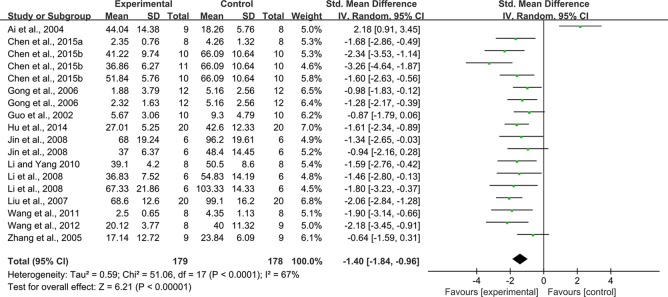
Pooled estimate of urine protein with rhein.